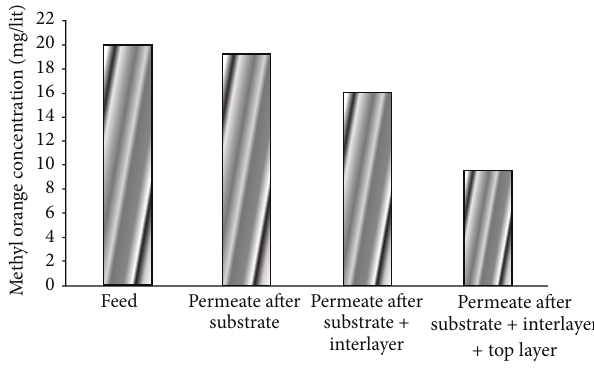
Figure 17: Concentration changes of MO solution before and after passing through the membrane substrate, interlayer, and top layer.